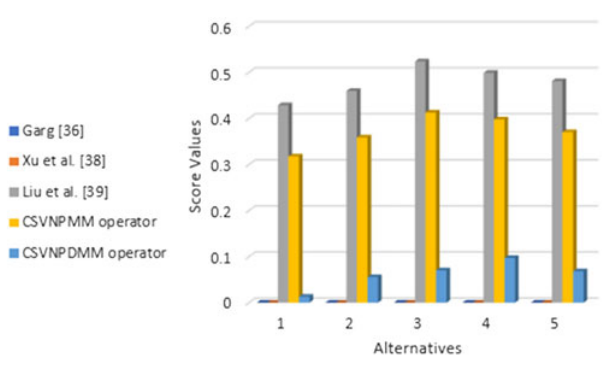
Graphical shown for the data given in Table